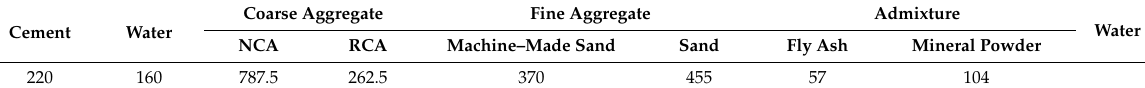
Figure 3. The strengthening principle.